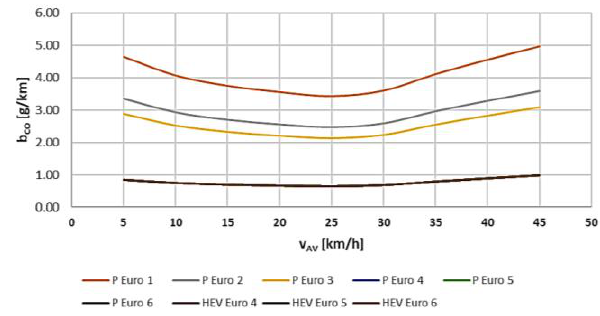
Fig. 29. CO emission from petrol PCs for Euro standards depending on average speed